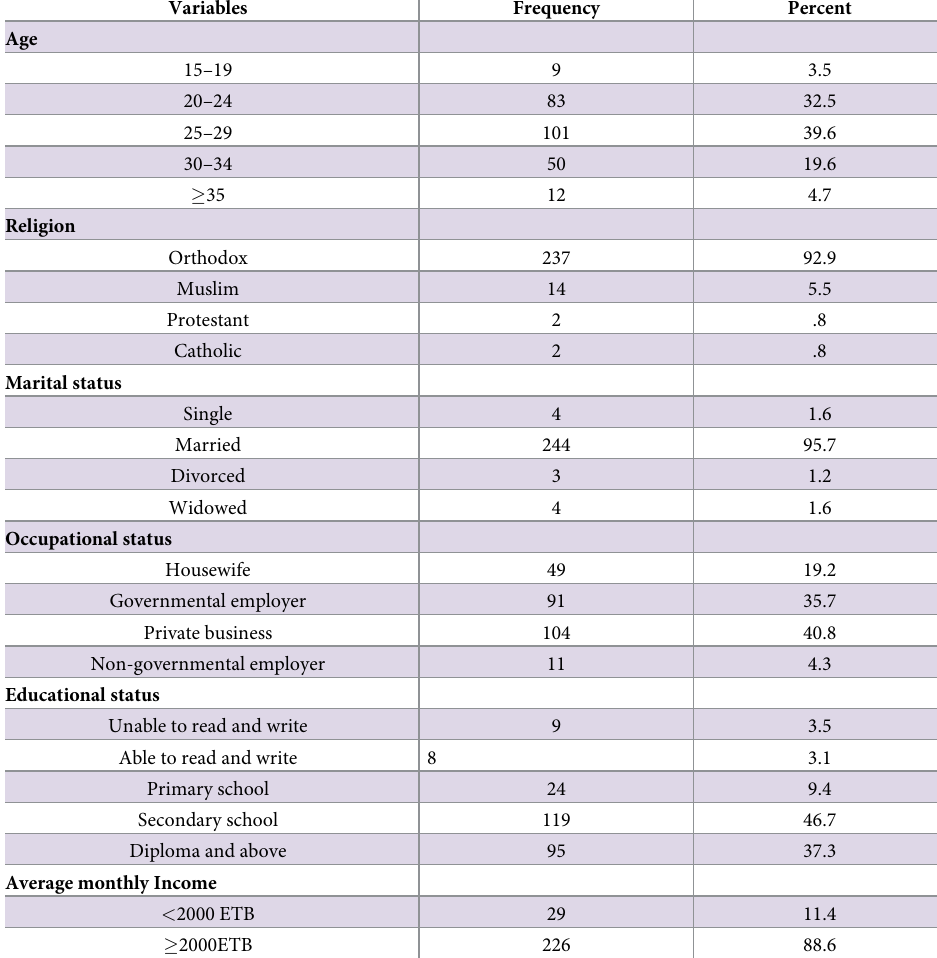
Table 1. Socio-economic characteristics of pregnant women attending ANC at health center in Mekelle city, Tigray, Ethiopia, 2020(n =